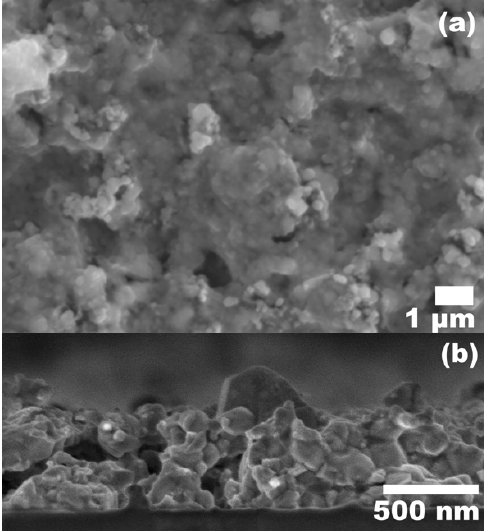
Table 1. Normalized EDS composition values for constituent CZTS film elements at different dilution levels of (NH 4 ) 2 S:H 2 O, standard solid concentration of 170 mg/mL.